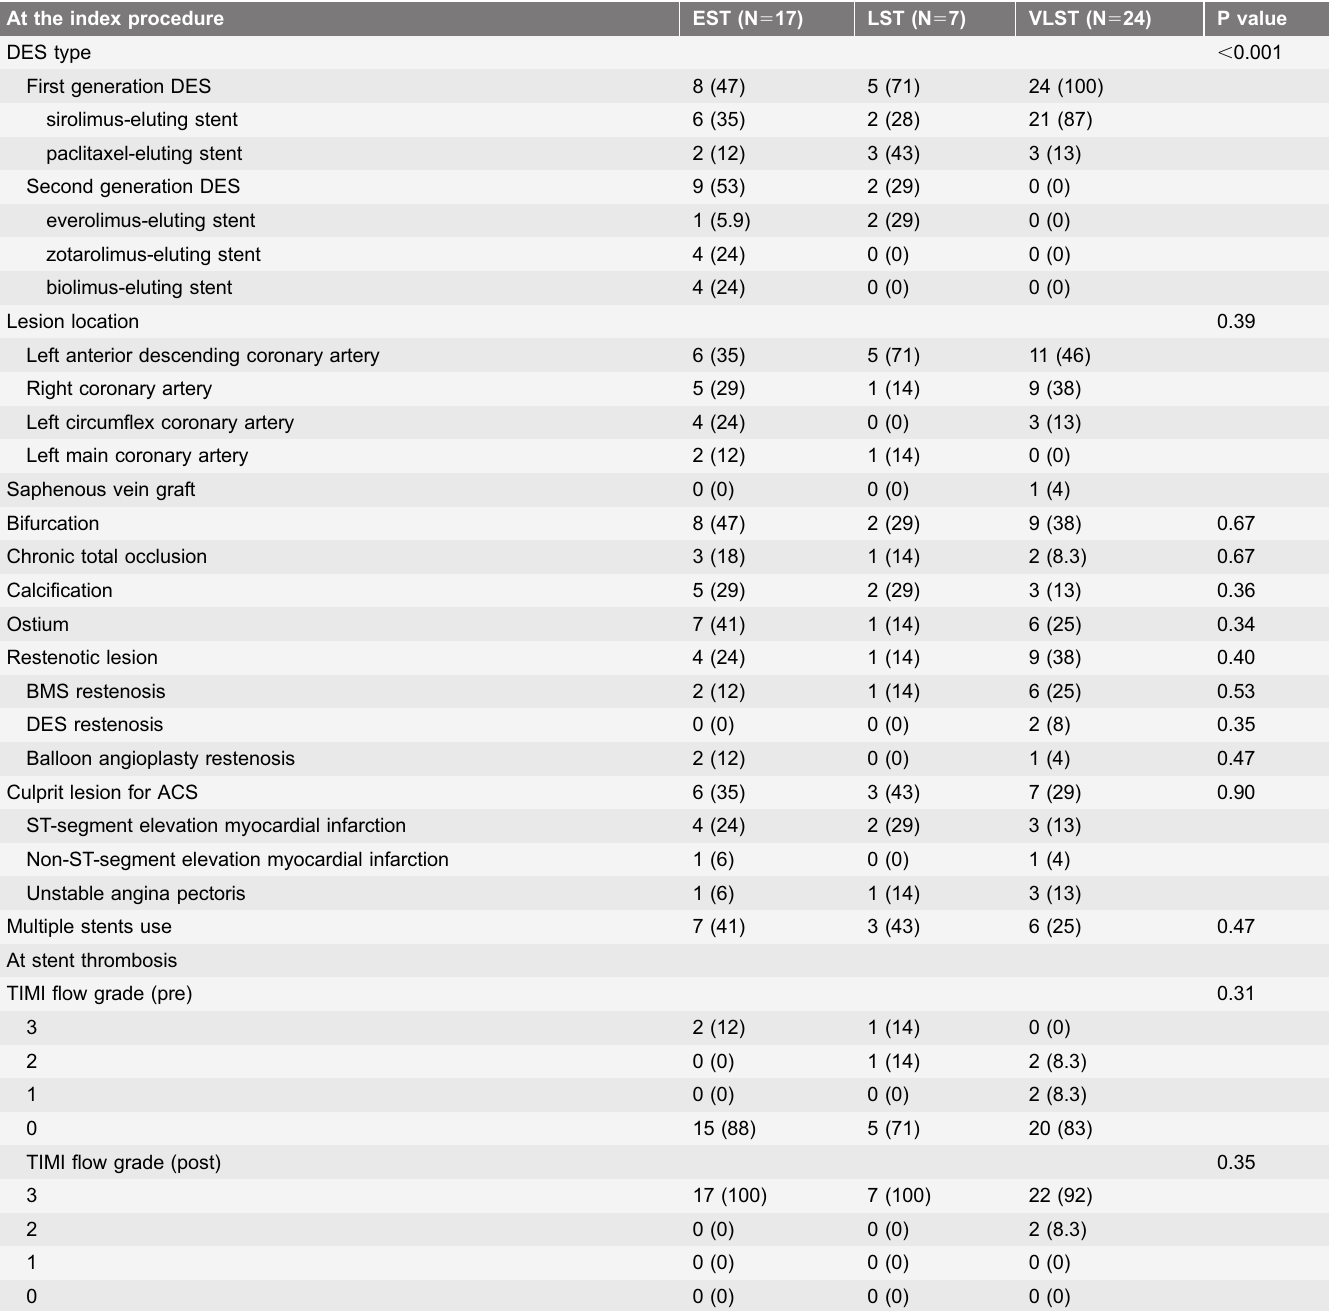
Table 2. Lesion Characteristics at the Index Procedure and Time of Stent Thrombosis According to the Timing of Stent